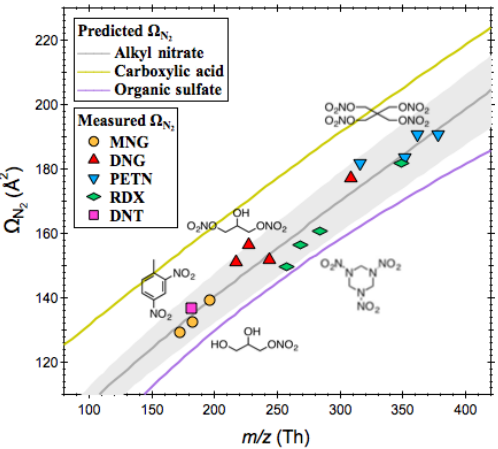
Figure 3. Measured collision cross sections ( (cid:127) N adducts as a function of their mass-to-charge ratios appear along the predicted (cid:127) N – m/z trend line. Also shown here are the pre- 2 dicted (cid:127) N – m/z trend lines for carboxylic acids and organic sul- 2 fates, which are major chemical classes of atmospheric interest de- tected in the negative ESI